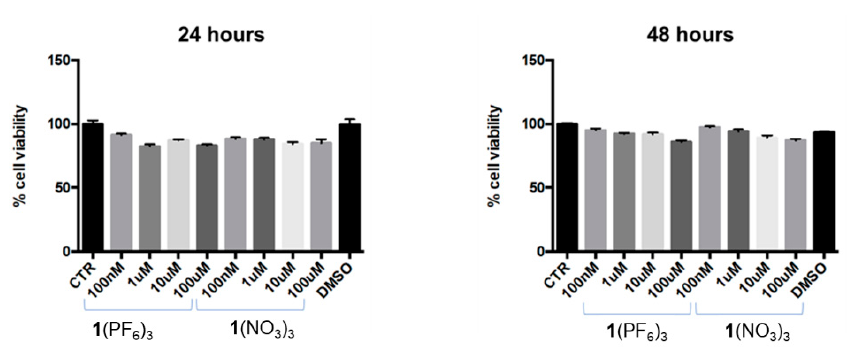
Figure 3. Effect of 1 (PF 6 ) 3 and 1 (NO 3 ) 3 salts on mitochondrial activity in SH-SY5Y cells. Cells were exposed to different concentrations of 1 (PF 6 ) 3 and 1 (NO 3 ) 3 for 24 h and 48 h. Absorbance values obtained after the MTT assay are expressed as mean percentages ± S.E.M. over controls (CTR, 100%),